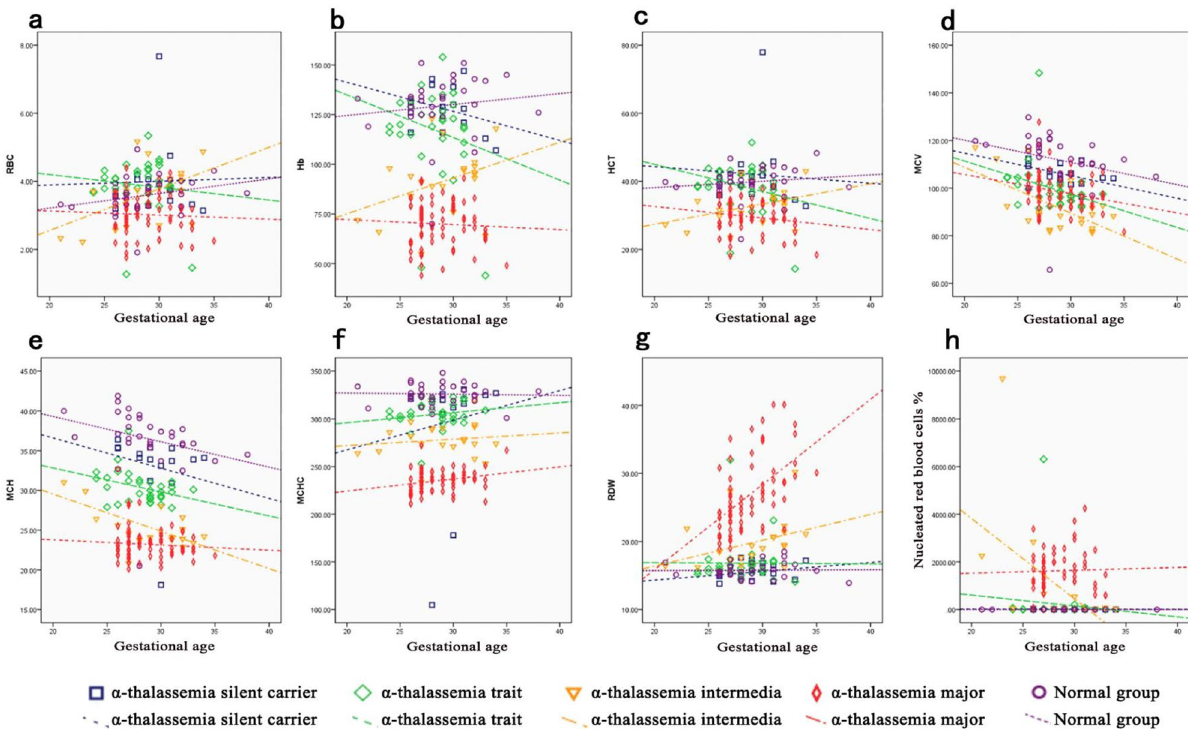
Figure 3. Distribution of red blood cell indices in four α-thalassemia genotypes at different gestational ages. The trends of RBC ( a ), Hb ( b ), HCT ( c ), MCV ( d ), MCH ( e ), MCHC ( f ), RDW ( g ) and nucleated erythrocytes ( h ) with increased gestational ages in four α-thalassemia genotypes carriers and normal group were illustrated.